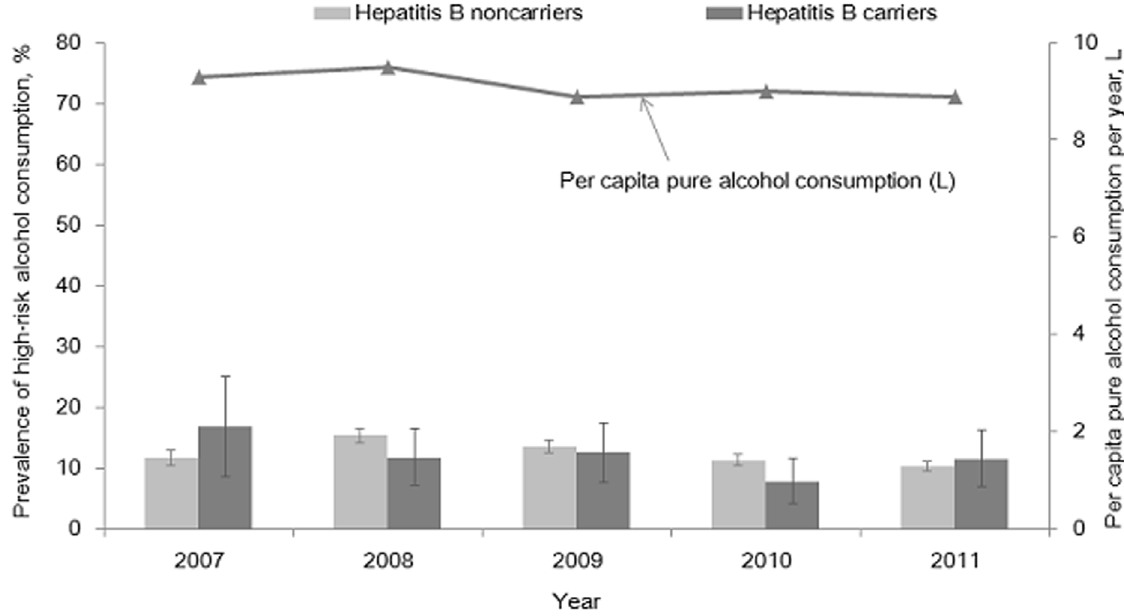
Figure 2. Trends in annual prevalence of high-risk alcohol consumption during the year of 2007–2011 among hepatitis B carriers and non-carriers aged 20 or older and per capita pure alcohol consumption per year in general population. The prevalence of high-risk alcohol consumption was calculated from Korean National Health and Nutrition Examination Surveys and Korean Statistical Information Service data was applied for per capita pure alcohol consumption.